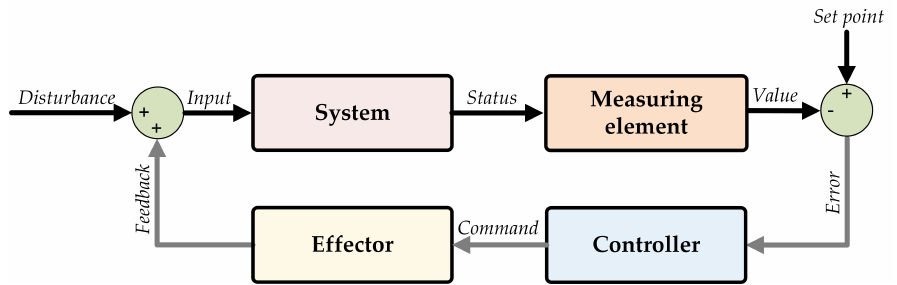
Figure 8. Feedback loop system flow